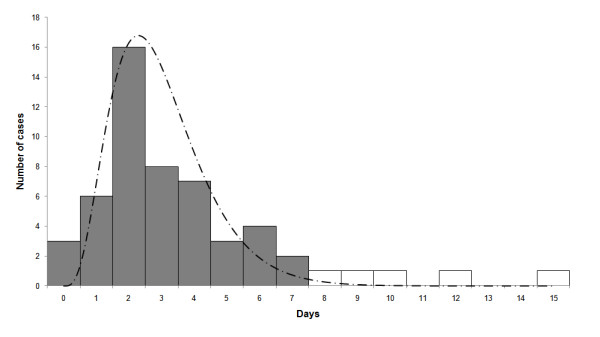
Frequency distribution of the swine flu generation time. This is based on differences in reported disease initiation dates that were calculated from our infection networks. Also displayed is a Gamma distribution curve (dashed line) based on data only up to seven days - dark bars (see text for details).